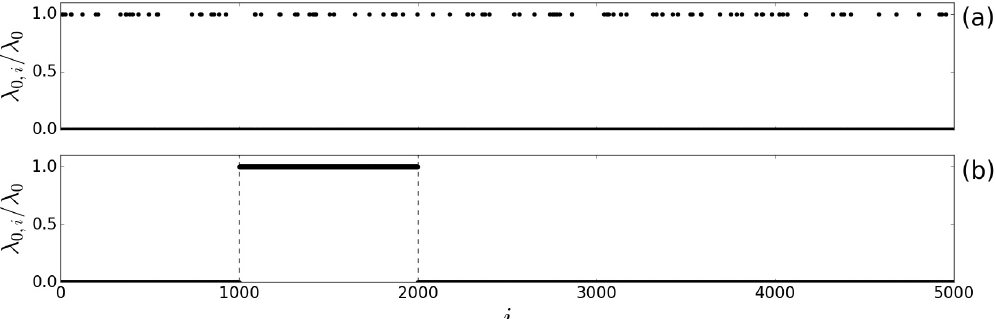
Figure 5. Amplitude of the external current λ 0, i for: ( a ) random subset of neurons; and ( b ) package subset of